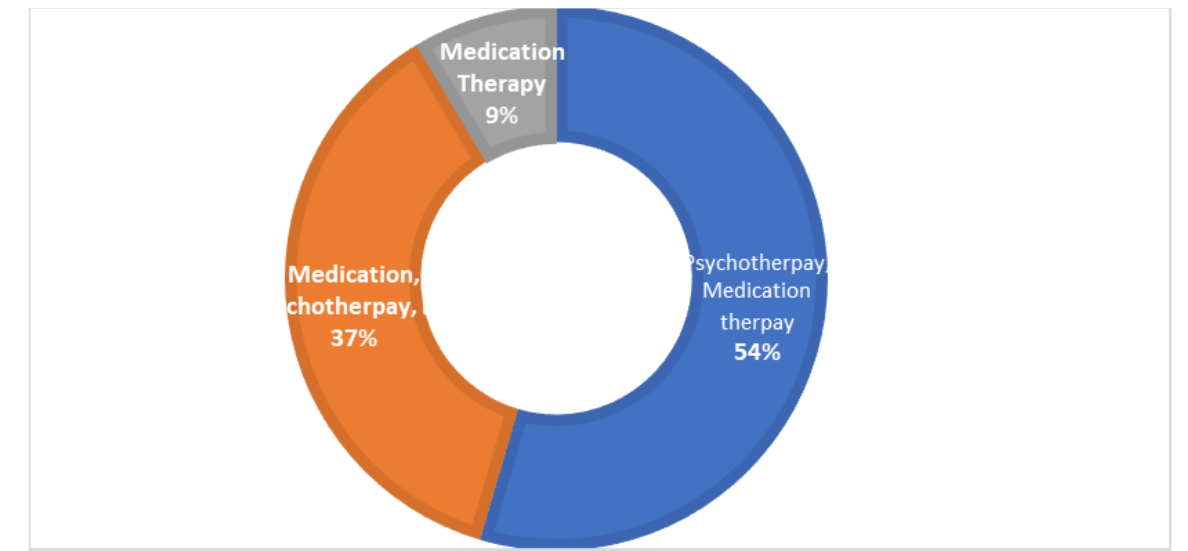
Figure 2. The pie donut chart represents different types of therapies used to treat the studied group of patients. Psychotherapy with medication therapy was given to 54% of the patients, medication therapy, psychotherapy and ECT combined were given to 37% of patients and medication therapy alone was given to 9%of the patients.